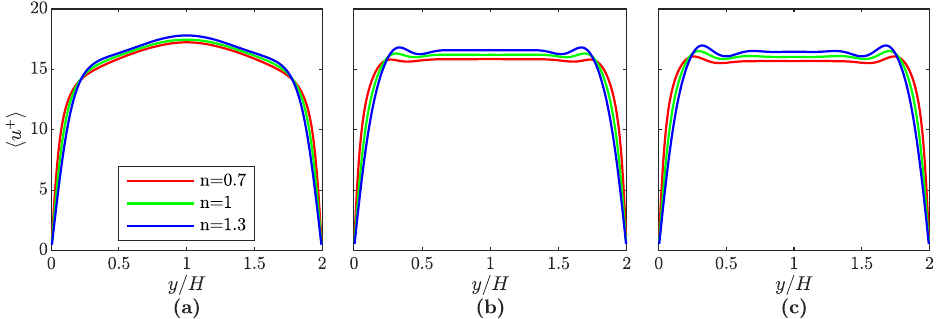
Figure 7. Average stream-wise velocity, normalized by the friction velocity of the initialization setup to yield (cid:104) u + (cid:105) , as a function of the wall-normal coordinate for the single-phase ( a ) and the two-phase setups with Eo = 0.3125 ( b ) and Eo = 3.75 ( c ).